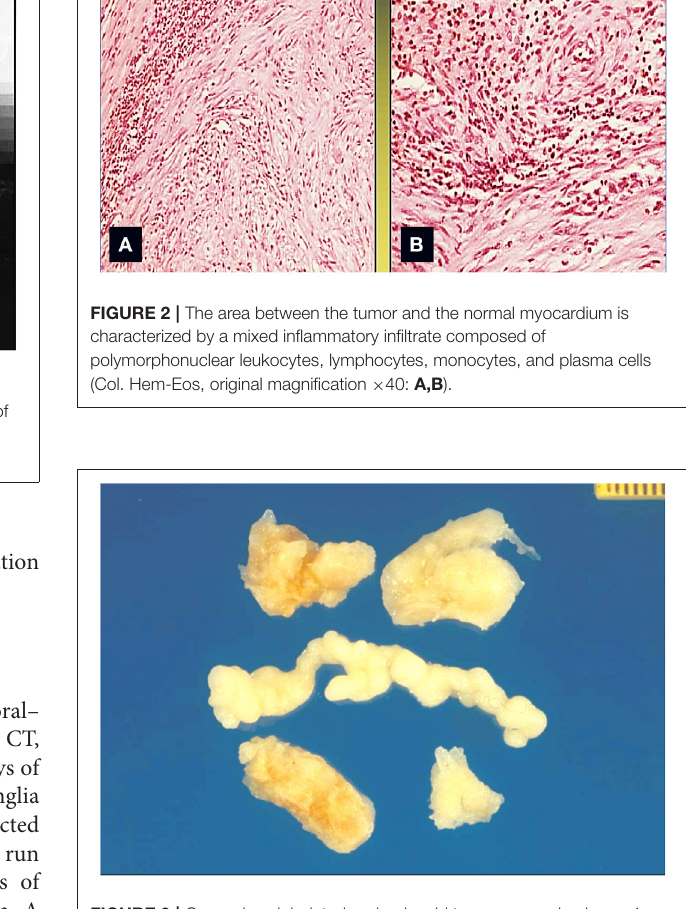
FIGURE 3 | Gross view: lobulated and polypoid tumor measuring in cm 4 × 0.3 × 0.2, of whitish color, and of elastic consistency. Compact tissue with focal mucoid degeneration was observed to